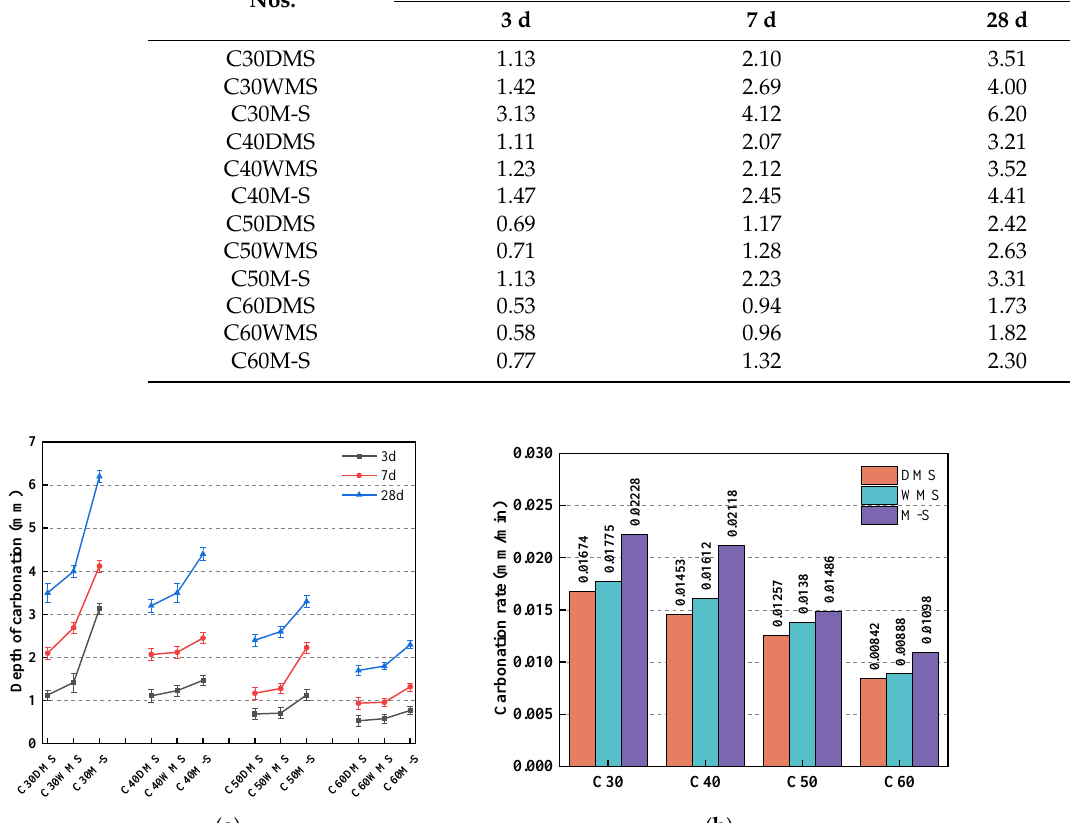
Table 9. Depth of carbonation of concrete at different ages. Nos.